Question: Name the type of graph shown.
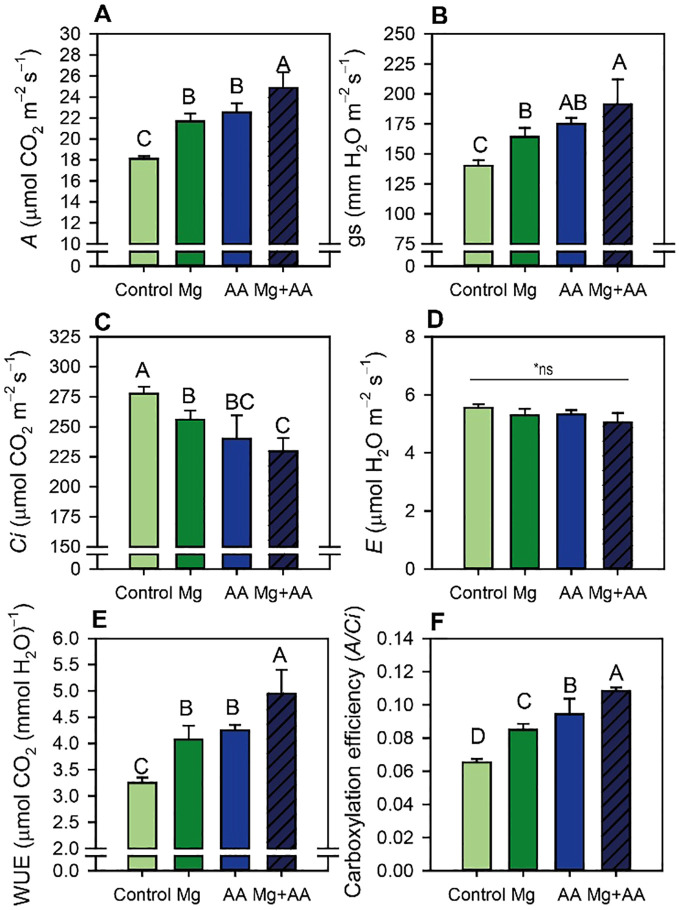
Answer: bar